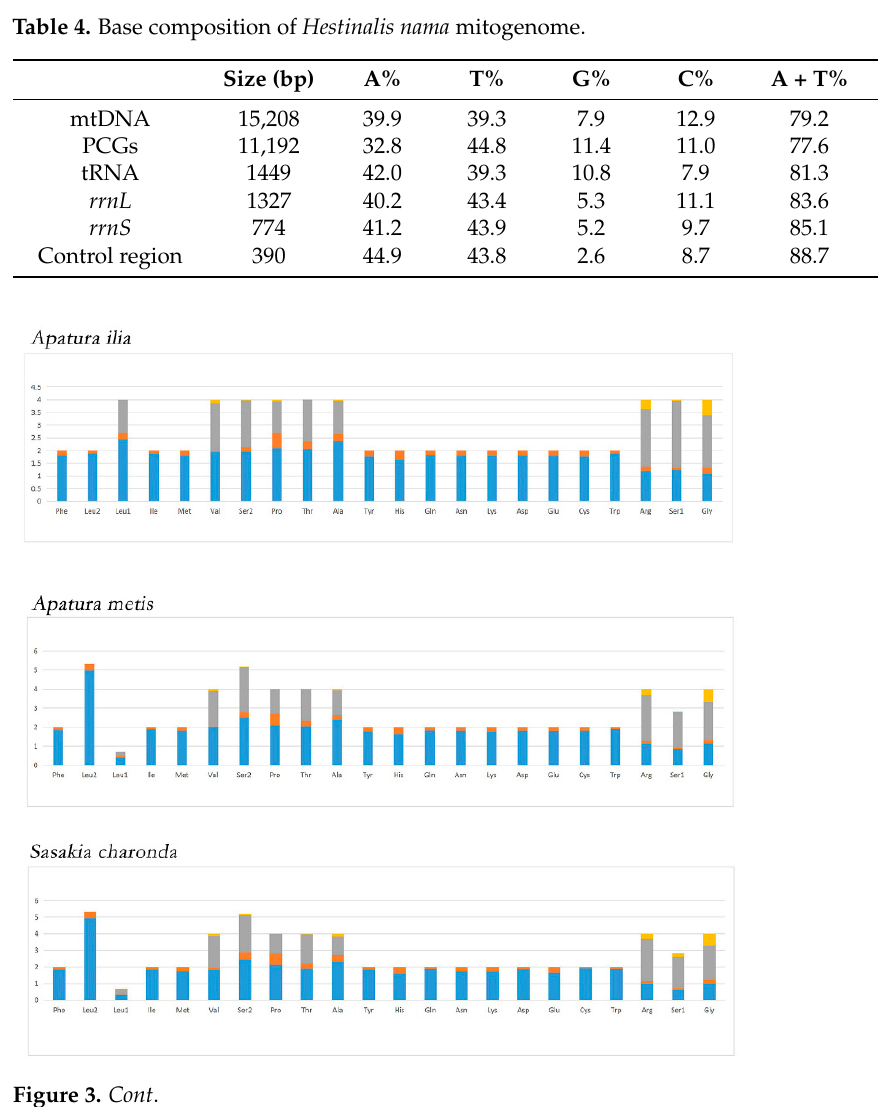
Figure 3. Relative Synonymous Codon Usage (RSCU) in the mitogenomes of twelve Apaturinae species. Codon families are provided on the X axis.